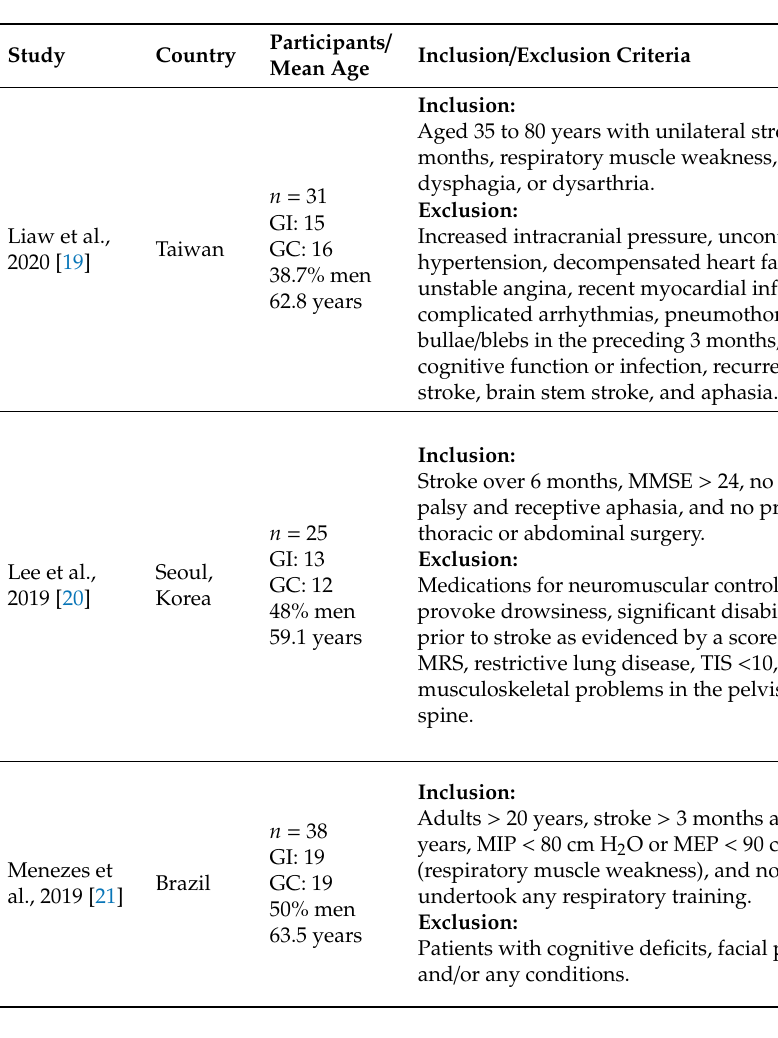
Table 1. Characteristics of studies